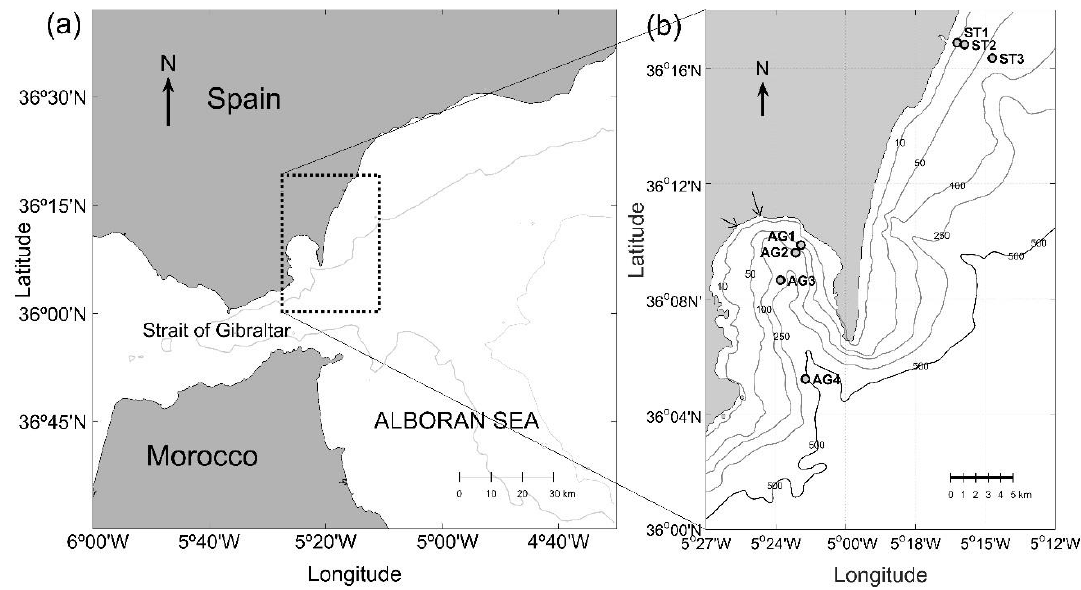
Figure 1. Area of study (panel a ) and location of sampling stations in the Bay of Algeciras (stations AG1–AG4) and Sotogrande (ST1–ST3). Thin black arrows in panel ( b ), indicate the position of the mouths of the two main rivers (Palmones and Guadarranque) within the Bay.